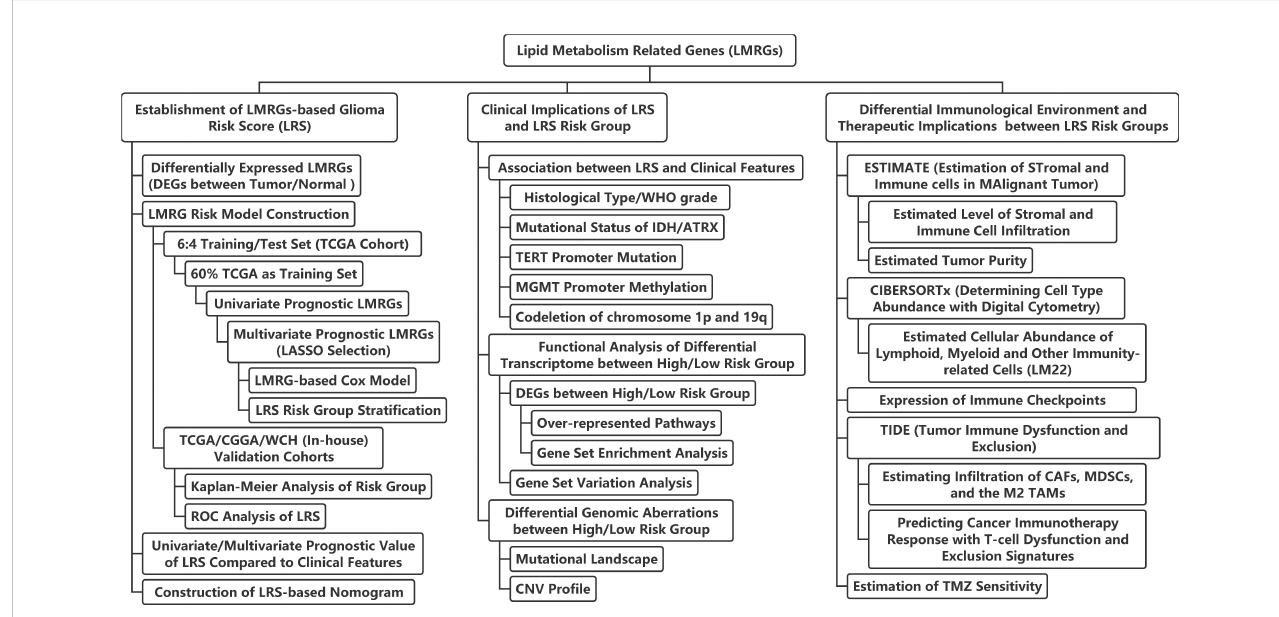
FIGURE 1 Flow chart of the current study. LASSO, least absolute shrinkage and selection operator; ROC, receiver-operator characteristics; IDH, isocitrate dehydrogenase; TERT, telomerase reverse transcription; MGMT, O6-methylguanine-DNA methyltransferase; ATRX, alpha thalassemia/mental retardation syndrome X-Linked protein/gene; CNV, copy-number variation; CAFs, cancer-associated fi broblasts; MDSCs, myeloid-derived suppressor cells; TAMs, tumor-associated macrophages; TMZ,